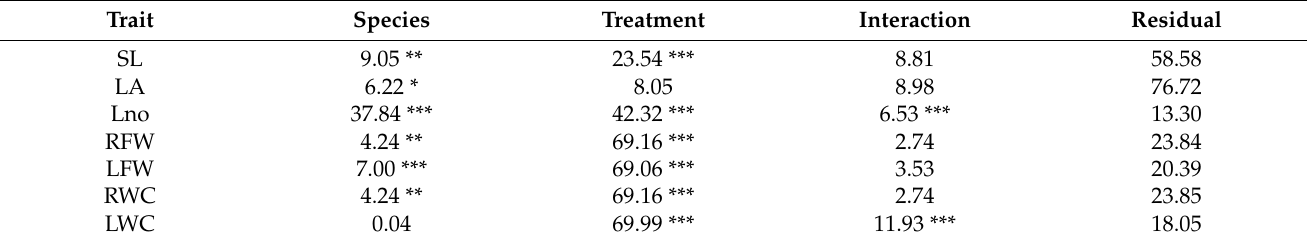
Figure 3. Images of plants after 1 month of treatments: ( a ) Erigeron bonariensis ; ( b ) E. sumatrensis . A two-way ANOVA was performed considering the factors species, treatment, and their interaction for all morphological traits analysed (Table 2). The strongest effect was that of treatment for all parameters except leaf area, where the data showed a large vari- ability and the variation between treatments was not significant. The effect of species was also significant for all parameters, except leaf water content, but not as strong as that of treatments, as shown by the lower percentages of the sum of squares. Table 2. Two-way analysis of variance (ANOVA) of species, treatment and their interactions for the growth parameters